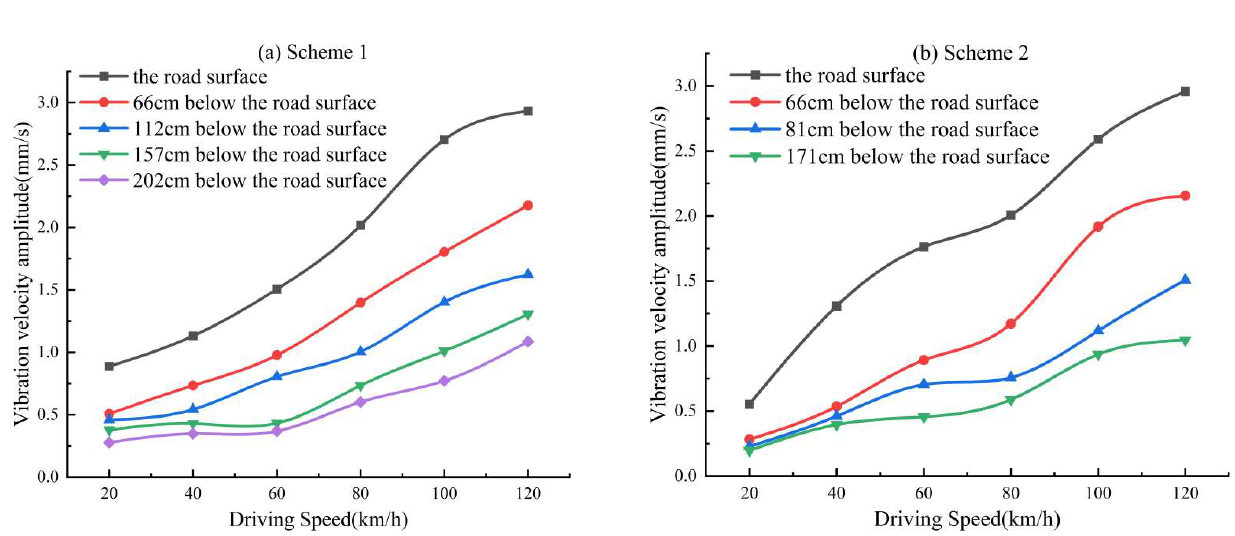
Figure 6. Actual vibration amplitude longitudinal decay curve.